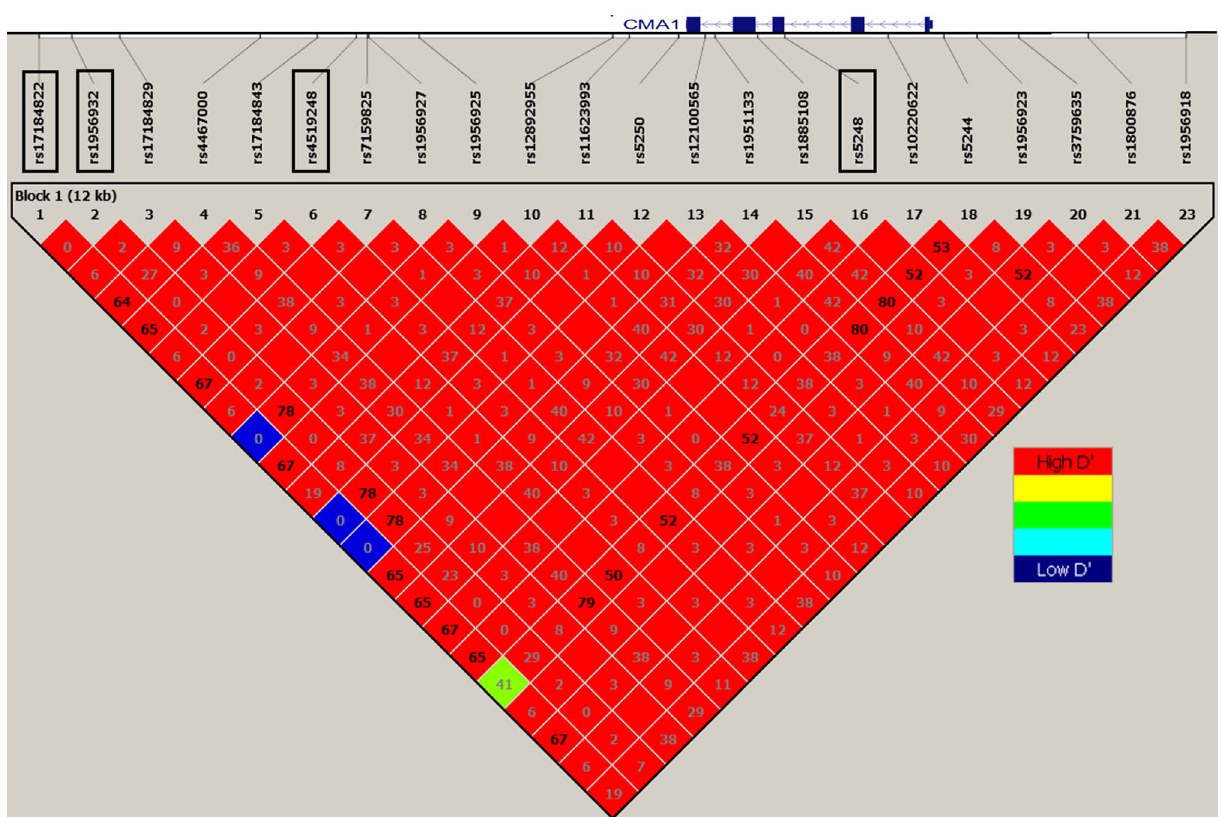
Figure 1. Linkage Disequilibrium structure at the CMA1 gene locus. Linkage Disequilibrium pattern (Heat Map) is represented by pairwise D 9 values between SNPs with MAF . 5% based on genotypes from HapMap (CEU population). r2 values (x100) calculated for each SNPs pair are given in the squares. Blank squares represent r2 values equal to 100. Rectangles are used to indicate Tagging SNPs.